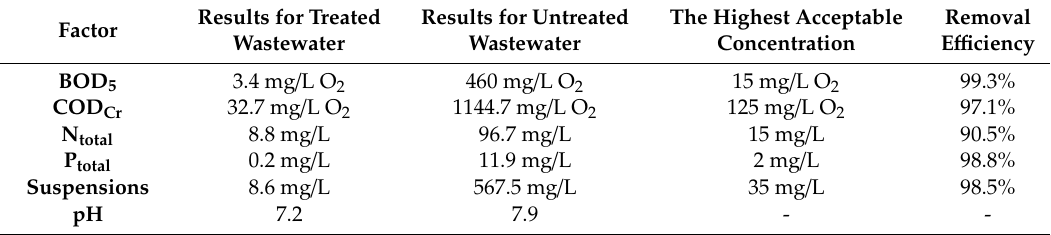
Table 6. List of sewage test results in the Municipal Wastewater Treatment Plant in Sochaczew (average values from